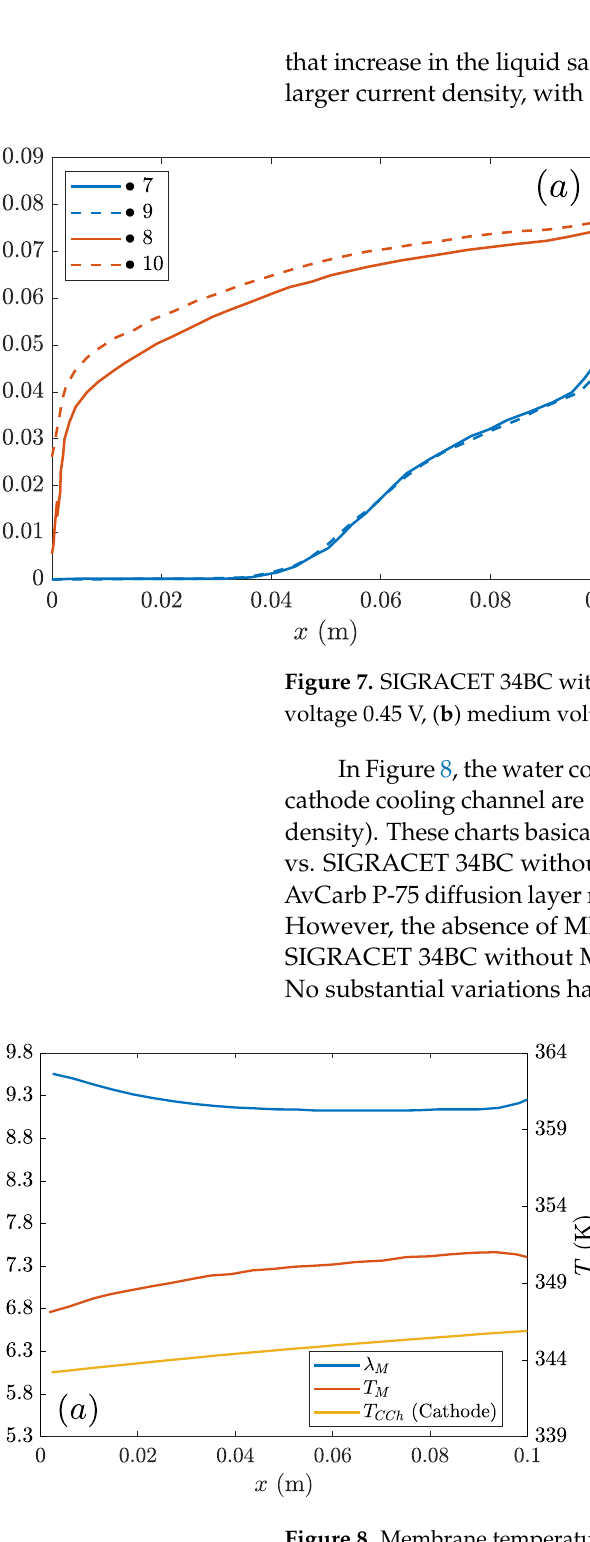
Figure 8. Membrane temperature, water content and cathode cooling channel temperature along the x -coordinate at low voltage (0.45 V): ( a ) AvCarb P-75 (MPL), ( b ) SIGRACET 34BC without